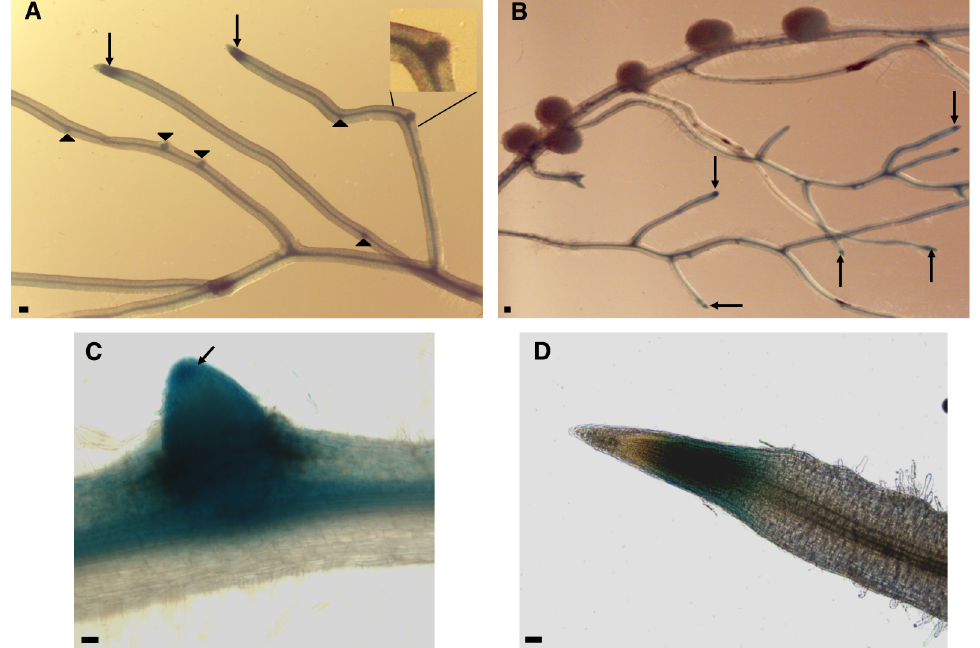
Figure 4. Representative β -glucuronidase (GUS) activity in L. japonicus hairy roots transformed with the pr LjAFB6 - gus A construct. ( A , B ) Arrows and arrowheads indicate staining in the meristems of primary/lateral elongated roots and in the lateral root primordia, respectively. ( C ) GUS activity in the root stele, in the emergence region of the lateral root and in the apical meristem (arrow). ( D ) GUS activity in the apical region of a primary root. Black bars on the left = 50 μm.